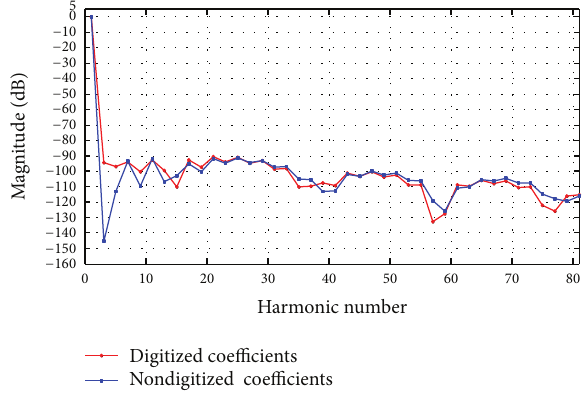
Figure 7: SFDR level for nondigitized and digitized optimal coeffi-